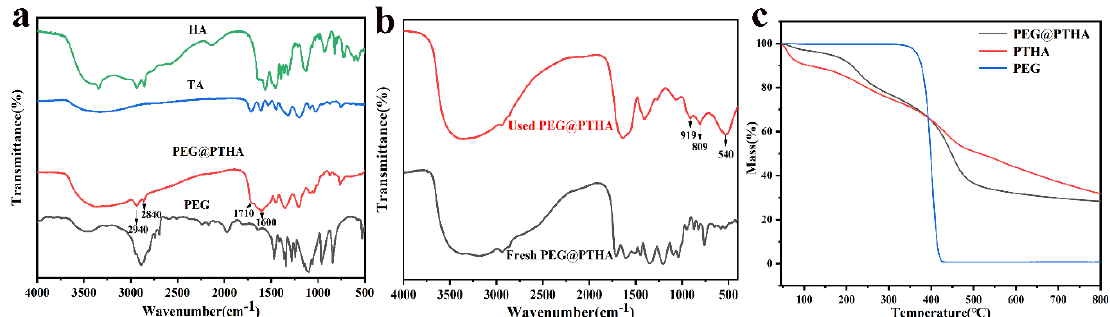
Figure 3. ( a ) FTIR spectrogram of HA, TA PEG, and PEG@PTHA, ( b ) FT-IR spectrogram of Fresh PEG@PTHA and used PEG@PTHA, ( c ) TGA curve of PEG@PTHA, PTHA, and PEG.